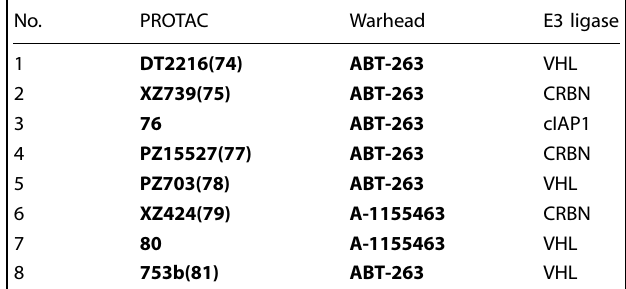
Table 3. The summary and comparison of PROTACs targeting Bcl-xl